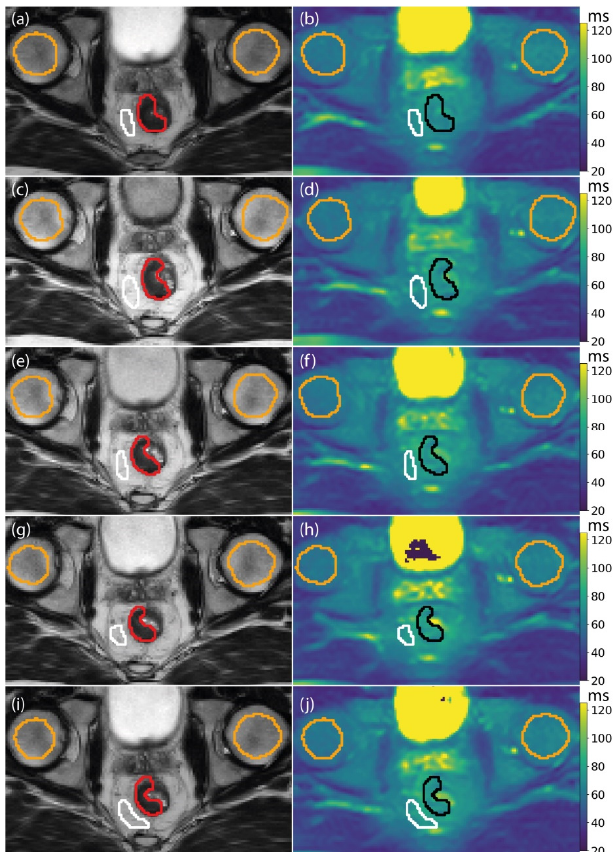
Figure 2. Example T 1 ρ maps of a single patient. Each row corresponds to a different treatment fraction. On the left, ( a , c , e , g , i ) the T 2 -weighted image used for delineation is shown, with the corresponding T 1 ρ maps on the right ( b , d , f , h , j ). The gross tumor volume (GTV) is shown in red on the T 2 -weighted image and in black on the T 1 ρ image. The mesorectum region of interest (ROI) is shown in white, and the femoral heads are shown in orange. The T 1 ρ maps are shown on a color scale from 20 to 120 ms. Baseline T 1 ρ values, measured on the first fraction before receiving the first radiation dose, were 77 ± 8 ms (mean ± SD of all patients) for the GTV; 73 ± 11 ms for the